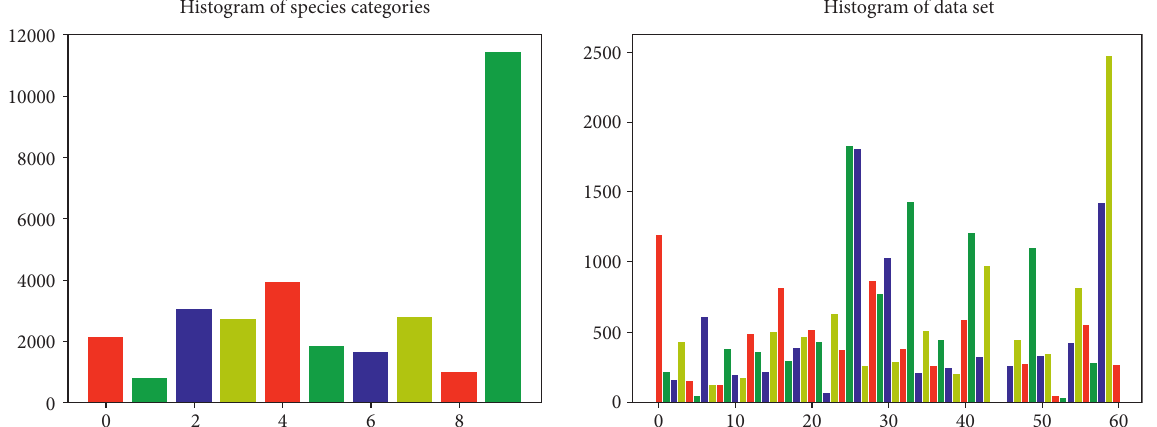
Figure 13: Plant species distribution and disease species distribution.